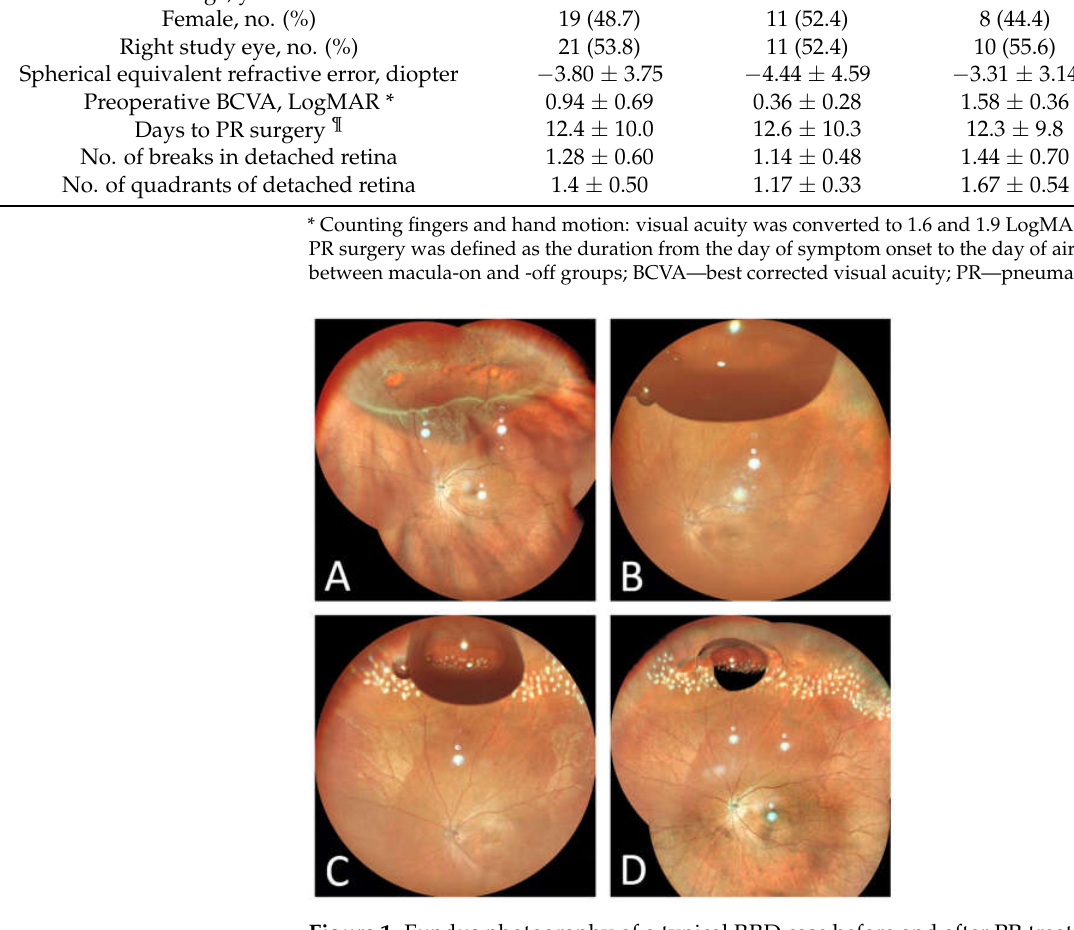
Figure 1. Fundus photography of a typical RRD case before and after PR treatment. ( A ). The patient had superior retinal detachment with multiple breaks. ( B ). The retina has completely reattached at 12 h after intravitreal air injection. ( C ) Laser retinopexy was applied the day after intravitreal air injection. ( D ) Laser retinopexy could be strengthened when the air bubble became smaller.